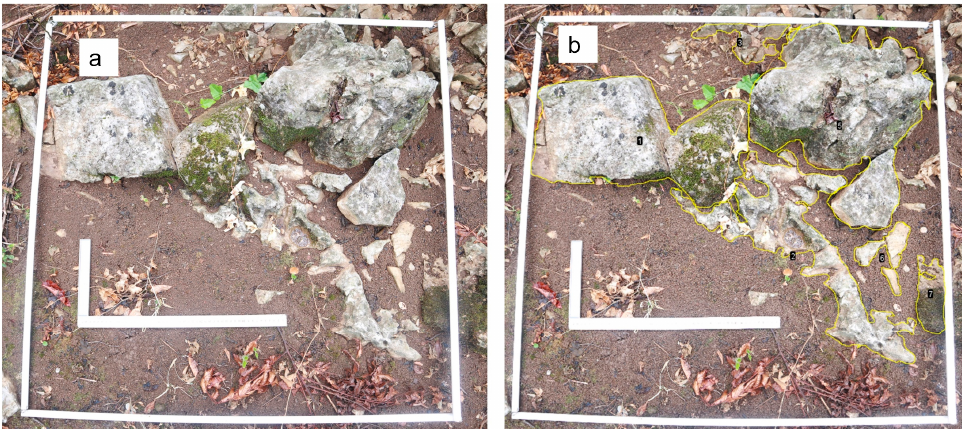
Figure 5. Measuring the percentage of surrounding limestone rock outcrops in AFS. The ( a ) is the original photo of 1 m × 1 m, and the ( b ) shows the rock area that was measured in the 1 m × 1 m. Second, the size and area of rocks covered by the soil surface (1 × 1 m) were